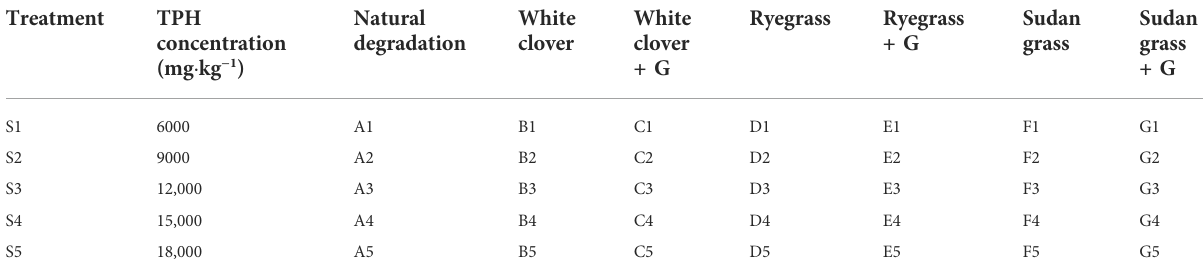
TABLE 3 Experimental design of glycine on petroleum hydrocarbons degradation in soil under different plant types conditions.